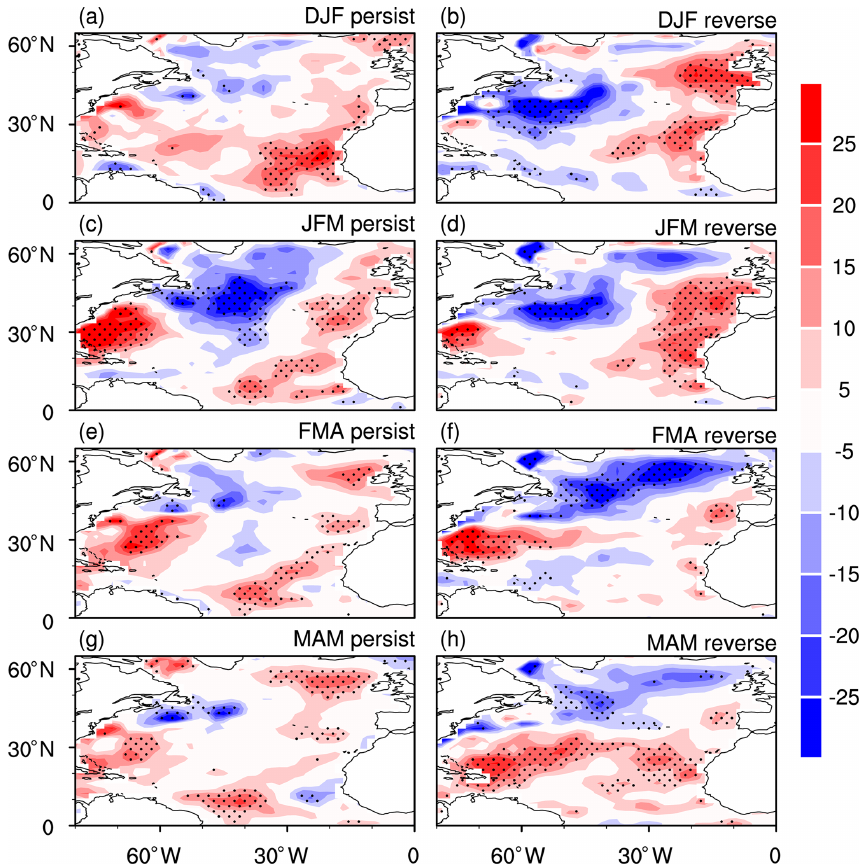
Figure 12. Composite anomalies of surface latent heat fluxes (Wm − 2 ) in (a, b) DJF, (c, d) JFM, (e, f) FMA, and (g, h) MAM for (left column) the persistent years and (right column) the reverse years. Stippled regions in the figure indicate anomalies that are statistically significant at the 5%